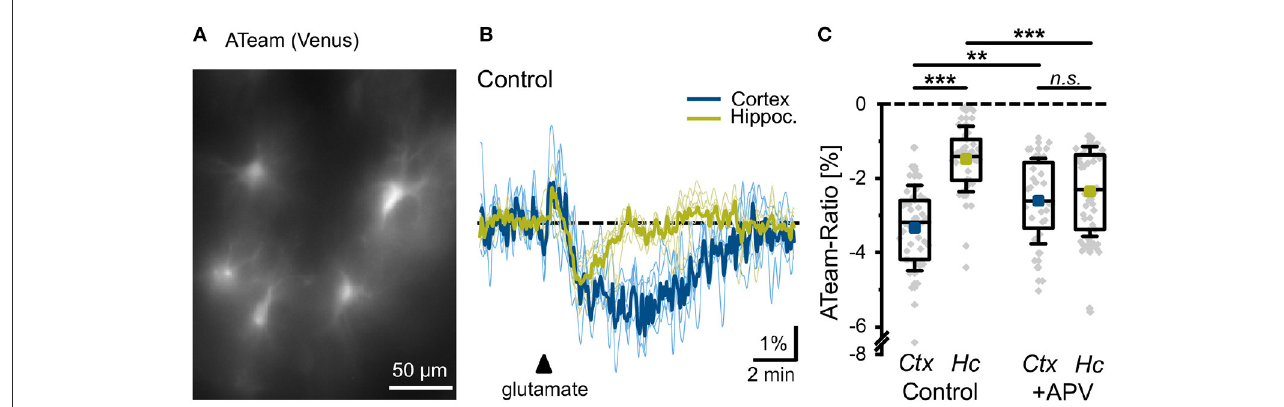
FIGURE8 Glutamate-evoked changes in astrocytic ATP. (A) Image of the Venus fluorescence of ATeam expressed under the GFAP promoter in an organotypic cultured slice of the mouse neocortex. (B) Changes in the ATeam ratio of two individual astrocytes in the somatosensory cortex (black trace) and the hippocampus (gray trace) evoked by a 10 s glutamate bath application (arrowhead). Traces were smoothed for illustration purposes using an FFT filter 3. (C) Box plots of peak changes in astrocytic ATeam ratio upon glutamate application in the neocortex (Ctx) and hippocampus (Hc) under control conditions and in the presence of the NMDA-receptor blocker APV. Shown are individual data points (gray diamonds), means (squares), medians (horizontal lines), IQ50 (boxes), and SD (whiskers). ** p < 0.01, *** p < 0.001, and n.s., not significant ( P =